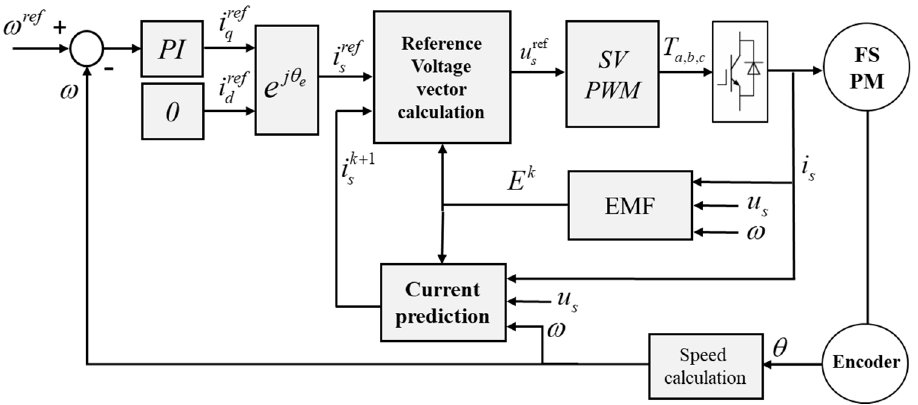
Figure 5. The as ‐ proposed modified model predictive current control (MPCC) control strategy.